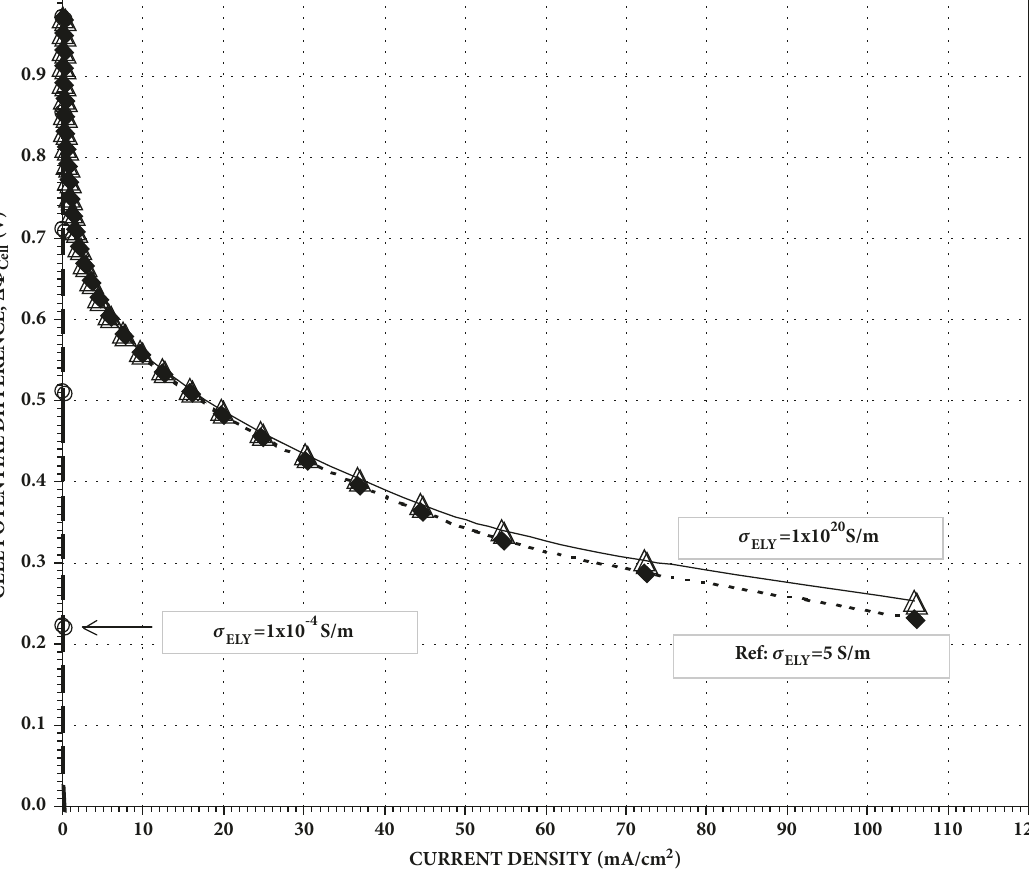
Figure 7: The effect of the membrane layer proton conductivity, 𝜎 (S/m), on the polarization curve for a direct propane fuel cell (DPFC) ELY model at 150 ∘ C and 1 atm. The values of 𝜎 (S/m) for the above three cases were represented by the following symbols: (i) open triangles: ELY 1x10 20 S/m, (ii) solid diamonds: 5 S/m (reference case), and (iii) open circles: 1x10 −4 S/m. All the other parameters were the same as the reference case mentioned in Table